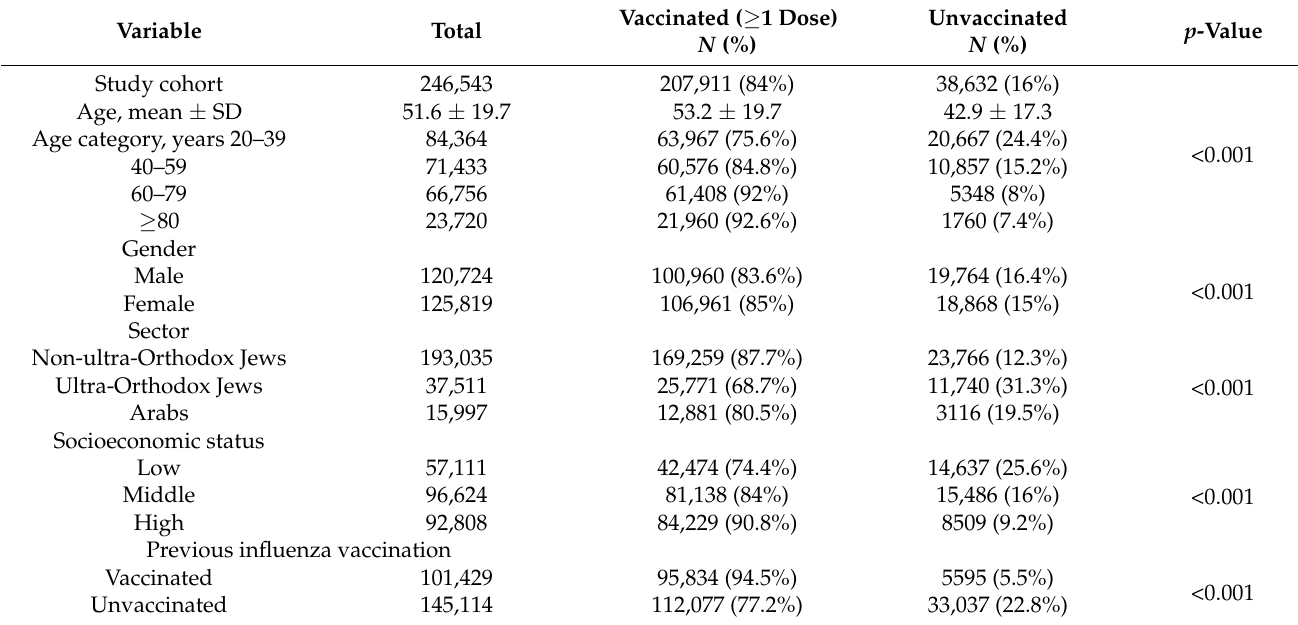
Table 1. Study group variables by COVID-19